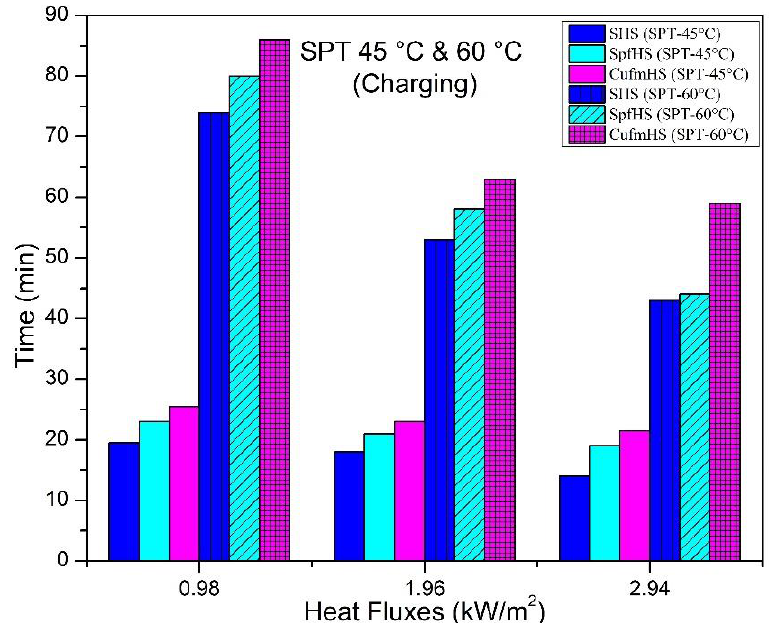
Figure 9. Operational time comparison at SPTs (45 – 60 °C) of different HSs for various heat fluxes.